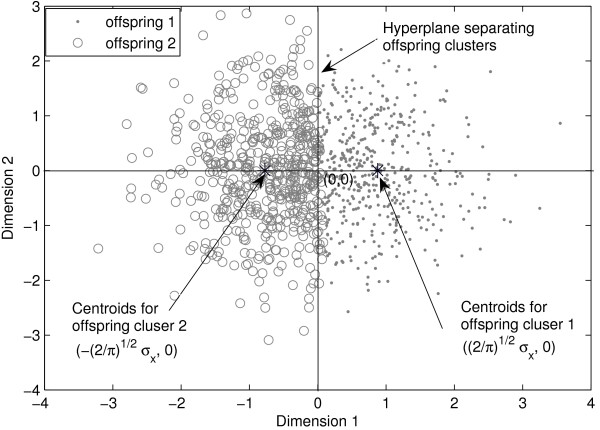
Artificial partitioning of natural cluster. A single natural cluster drawn from Gaussian distribution with mean at origin and identity covariance matrix. k-means clustering partitions this single cluster into two clusters separated by hyperplane.